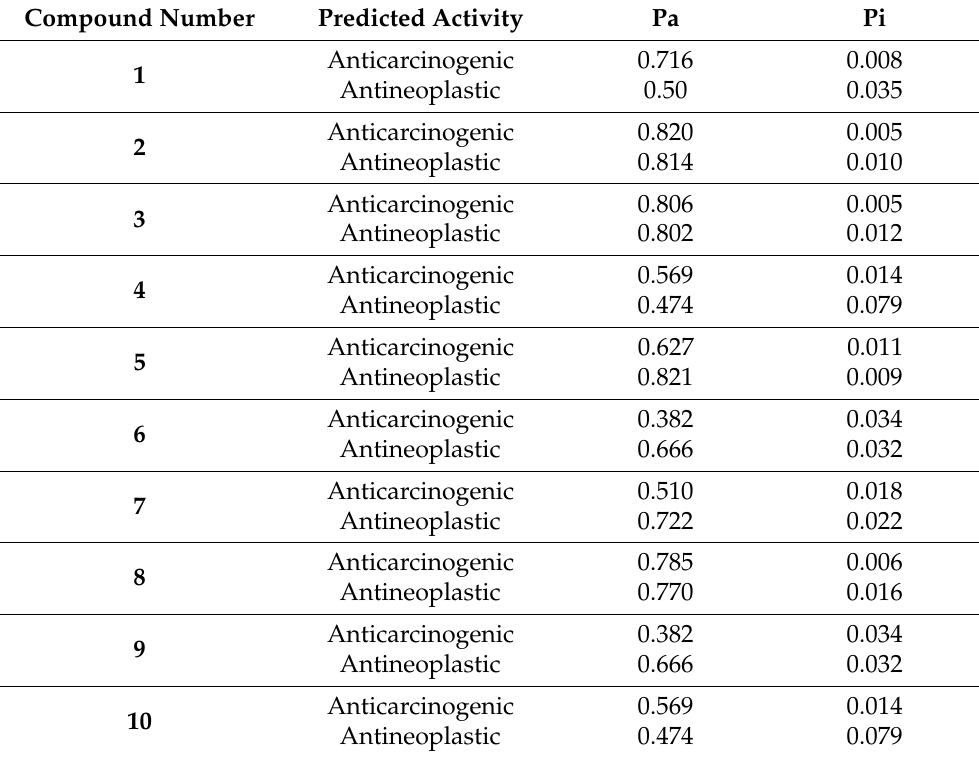
Table 3. The Prediction of Cytotoxic Activity of Aloe perryi Active